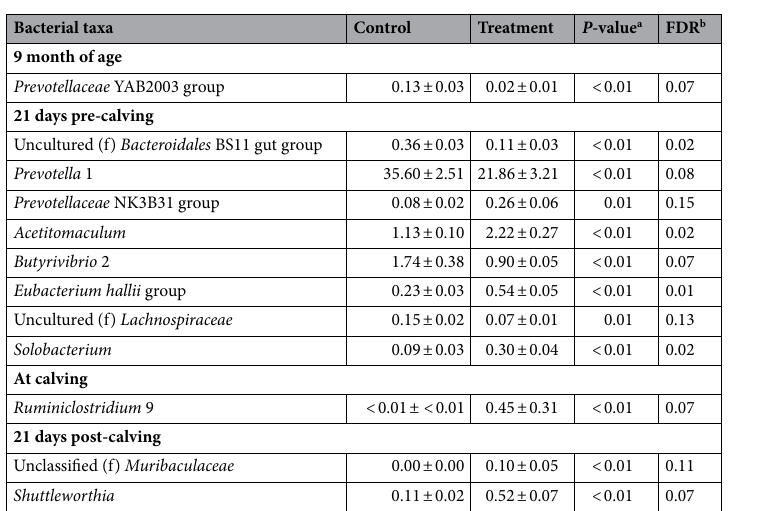
Figure 4. Change in the ruminal bacterial community structure in adult cows. The PCoA plot was generated based on Bray–Curtis dissimilarities in rumen bacterial communities determined via 16S rRNA gene amplicon sequencing for respective ages; ( a ) 9 months, ( b ) 60 days pre-calving, ( c ) 21 days pre-calving, ( d ) at calving, and ( e ) 21 days post-calving. Individual points in each plot represent individual animals. Colors indicate the dietary groups; control (yellow) and treatment (blue). P -values of the diet effect at 9 months ( P = 0.02), 60 days pre- calving ( P = 0.12), 21 days pre-calving ( P = 0.05), at calving ( P = 0.58), and 21 days post-calving ( P = 0.03) were calculated using PERMANOVA test.